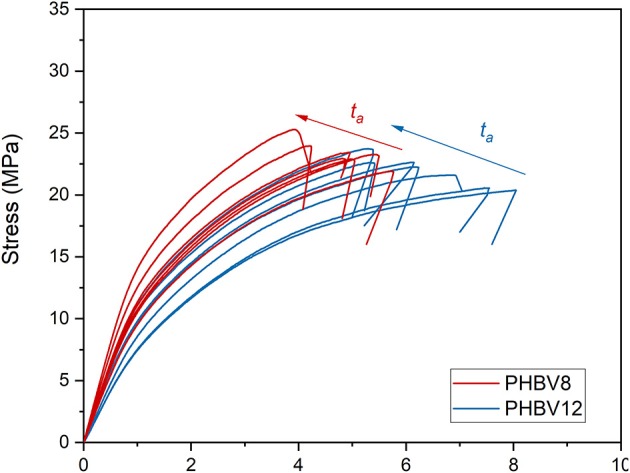
Stress-strain curves for PHBV8 and PHBV12 after different tas at Troom.